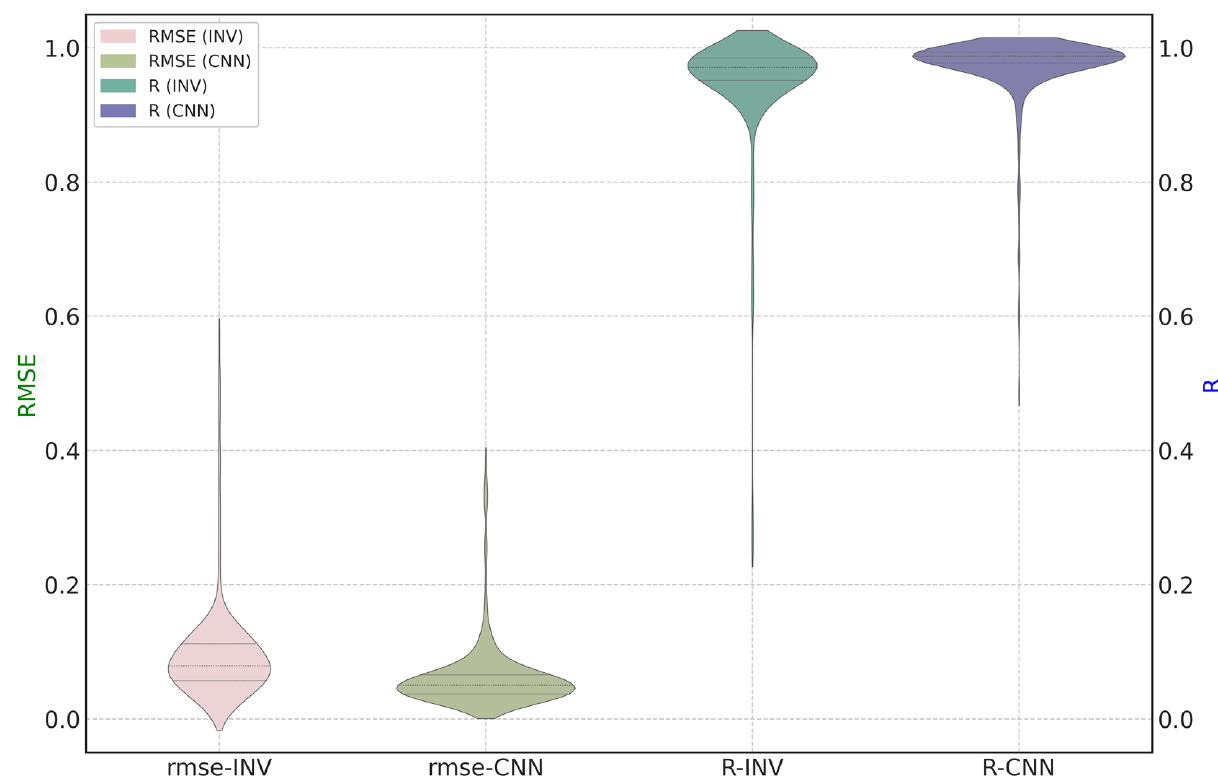
Figure 6. Violin plot of statistic distributions based on 300 results using CNN and traditional iterative inversion (INV). Table 2. The calculated 𝑅 and RMSE using CNN and iterative inversion with 300 models.